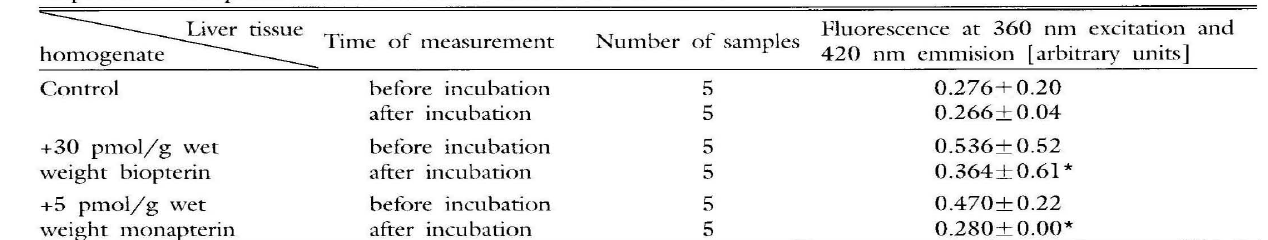
Table 2. Fluorescencc (mcan±S.D. ) of samples conta1l1111g rat livcr tissue homogcnate without (control ) or with biopterin or monapterin before and after incubation for 8 h at